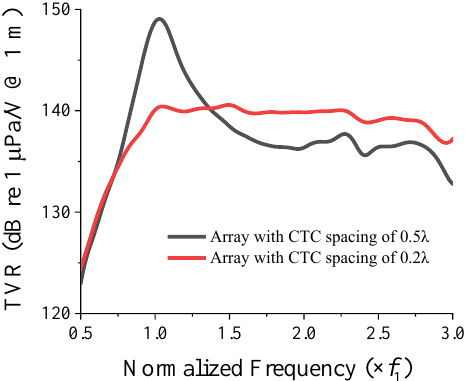
Figure 12. TVR spectrum of the two-layered array with CTC spacings of 0.5 𝜆 and 0.2 𝜆 .